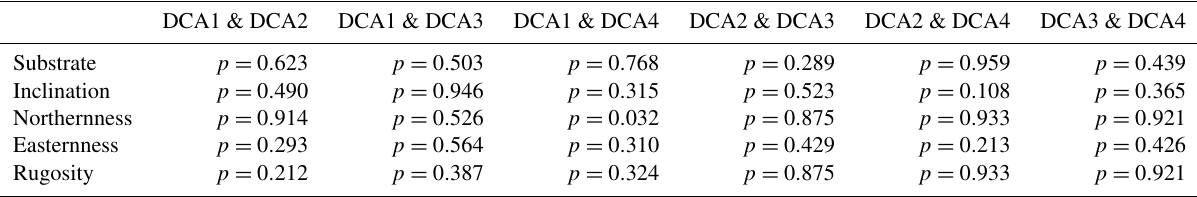
Table A3. A post hoc permutation test (10000 repetitions) between the DCA ordination axes and the environmental variables (substrate, inclination, aspect, and relief) showed no significant differences between phonolite and basalt. Obviously, the variation shown in the DCA does not depend on the substrate (but there is a relationship between northernness and the fourth dimension